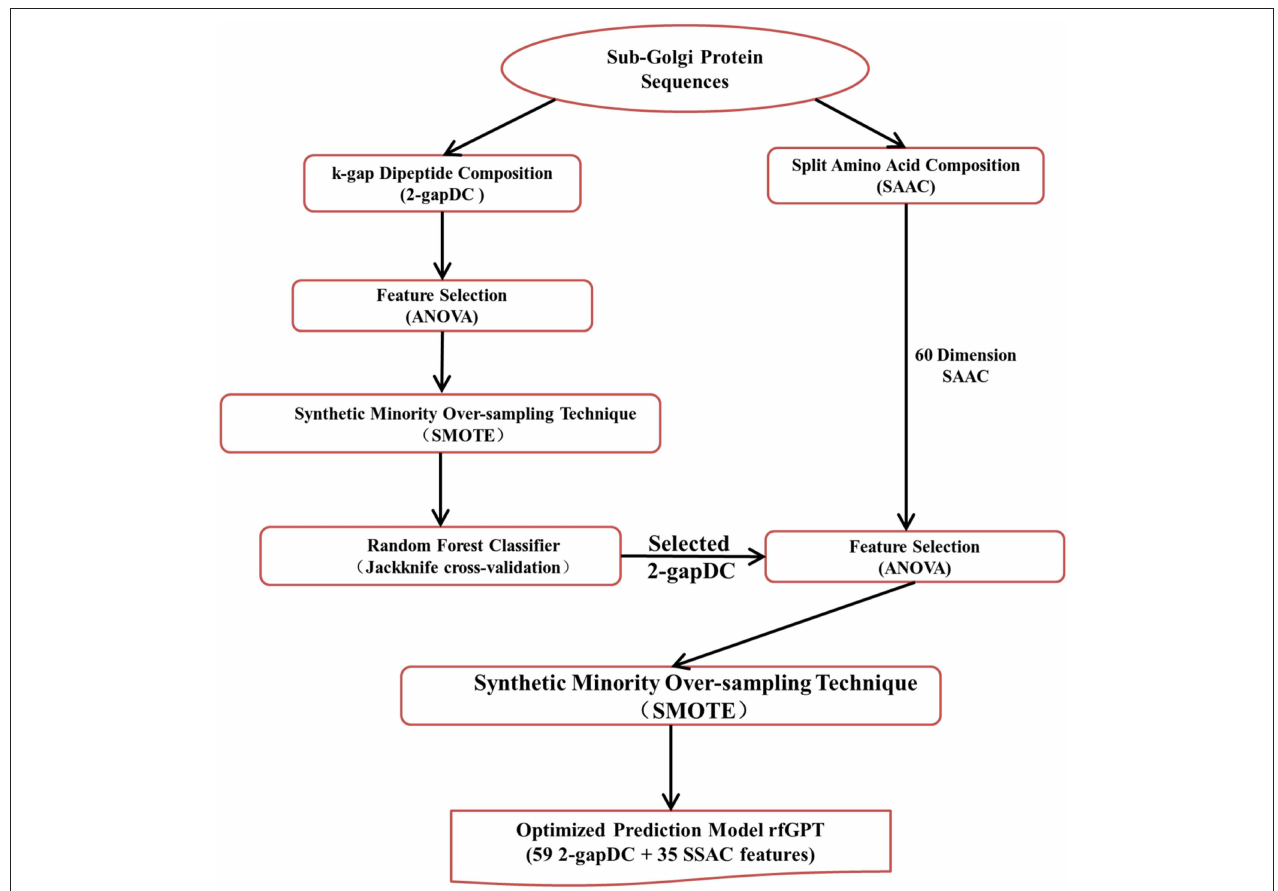
FIGURE 1 | Modeling framework of the state-of-art random forests sub-Golgi protein classifier. ANOVA: analysis of variance.